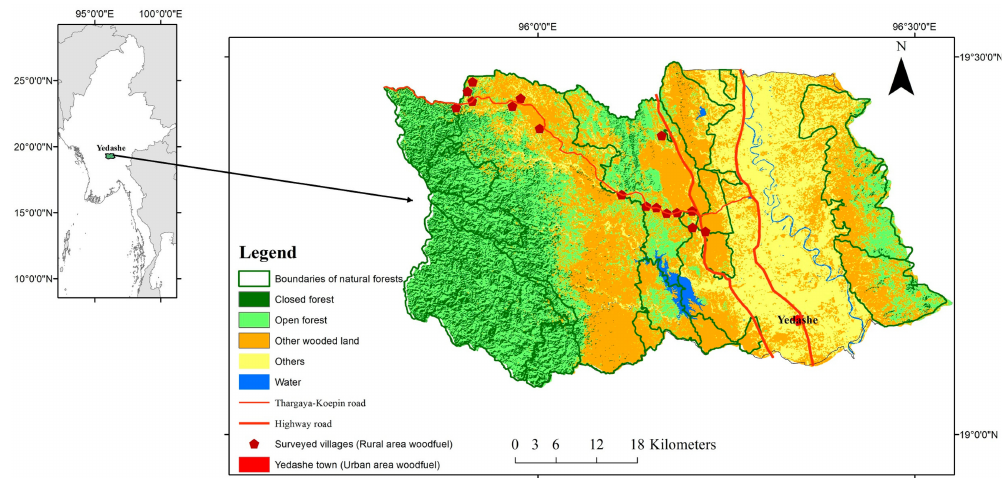
Figure 1. Location of the Yedashe town surveyed in this present study and the rural villages sampled by Win et al. [18] in Bago region, Myanmar. The World Borders Dataset, provided by Thematic Mapping (http://thematicmapping.org/), was used for the national border. The administrative boundary provided by the Myanmar Information Management Unit (http://www.themimu.info/) was used for the township boundary. Data about land cover and roads were obtained from the Forest Department of